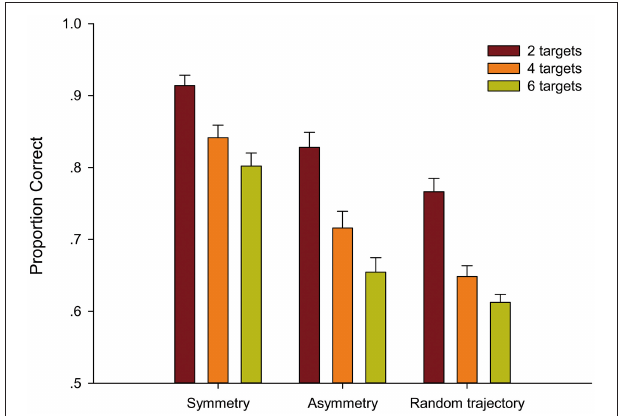
FIGURE 3 | Average proportion correct as a function of target number and target position and standard error in Experiment